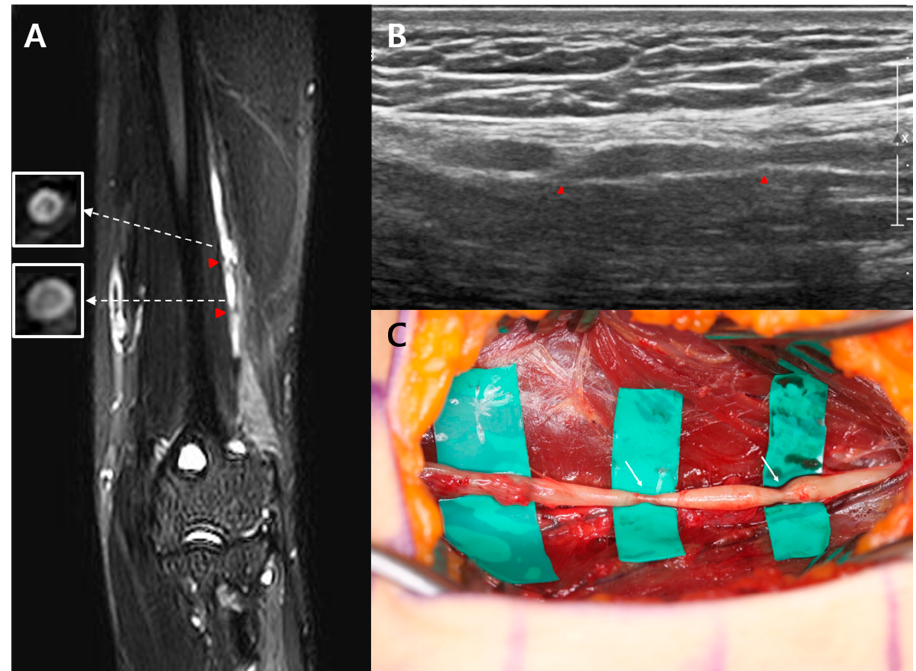
Figure 2. Case 2: ( A ) High-resolution magnetic resonance neurography reveals two focal constrictions (red arrowhead) of the left radial nerve 8.0 and 6.9 cm proximal to the lateral epicondyle, respectively. A bull’s eye sign (in white square) is observed juxta-proximal to each constriction site of the left radial nerve; ( B ) Longitudinal ultrasound reveals two constrictions (red arrowheads) of the left radial nerve; ( C ) Intraoperative findings confirm two constrictions (write arrow) of the left radial nerve.